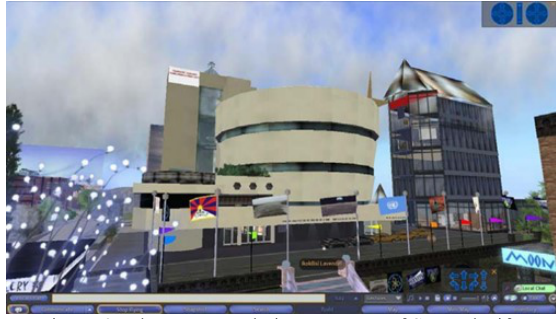
Figure 2: The Newggenheim Museum of Second